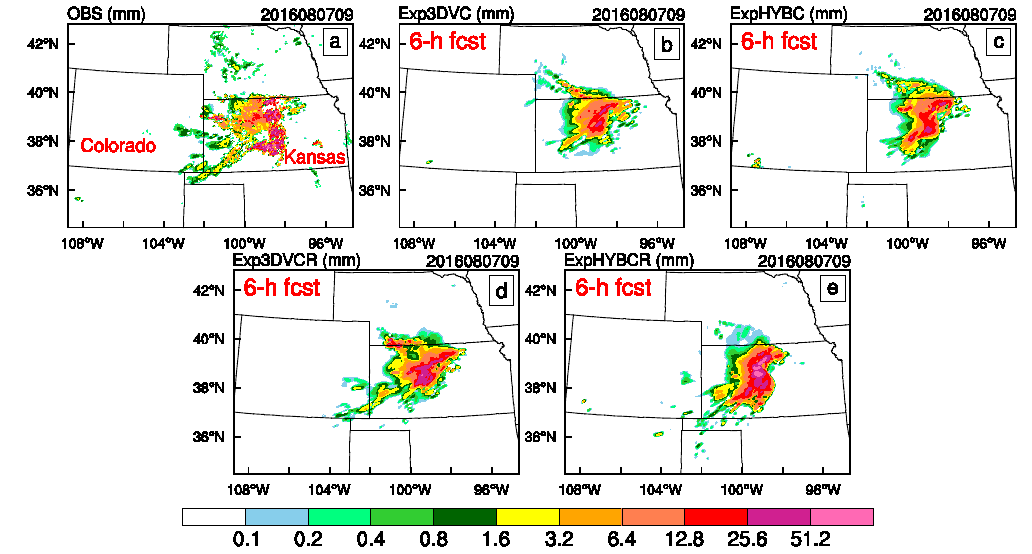
Figure 10. One-hour accumulated precipitation (unit: mm) of: observation ( a ); Exp3DVC ( b ); ExpHYBC ( c ); Exp3DVCR ( d ); and ExpHYBCR ( e ) of the convective system at 09:00 UTC on 7 August 2016 (initialized at 03:00 UTC on 7 August 2016).